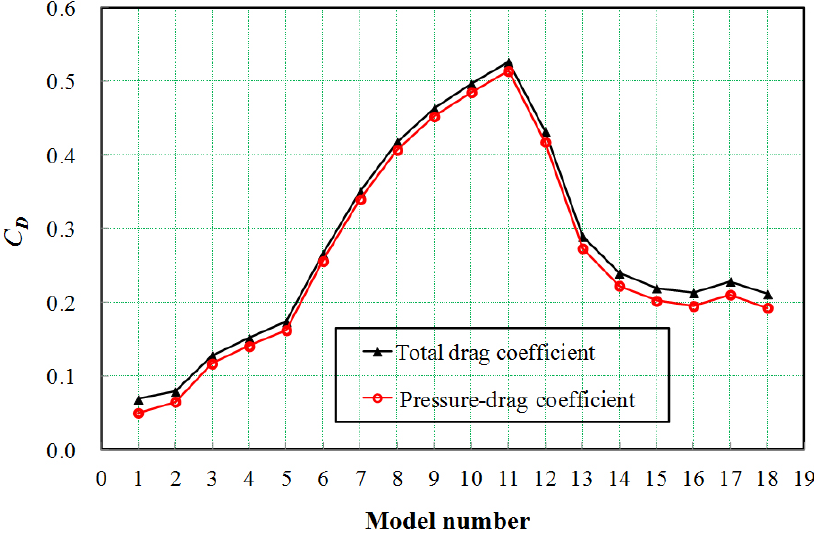
Figure 12. Variations in drag coefficient with the model number.